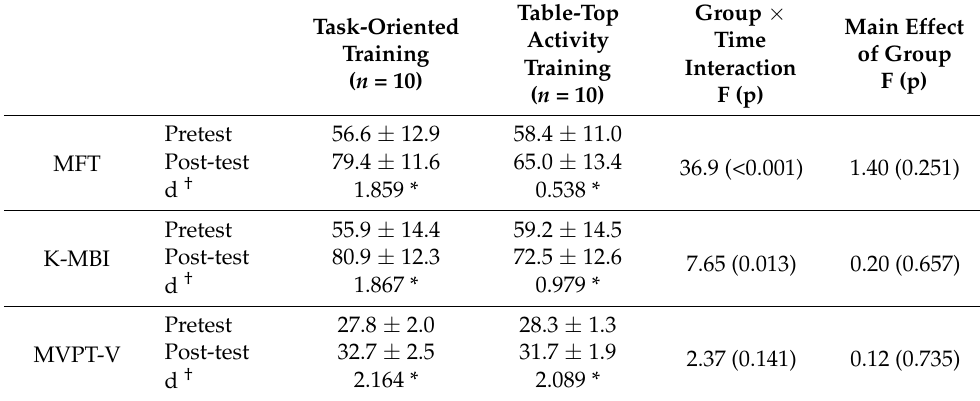
Table 4. Outcome variables before and after the interventions between the groups ( N = 20).